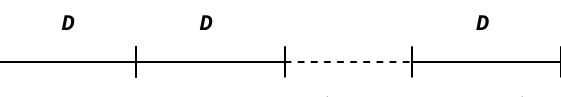
Figure 2. Multiple-site traverses (n+1 sites, n